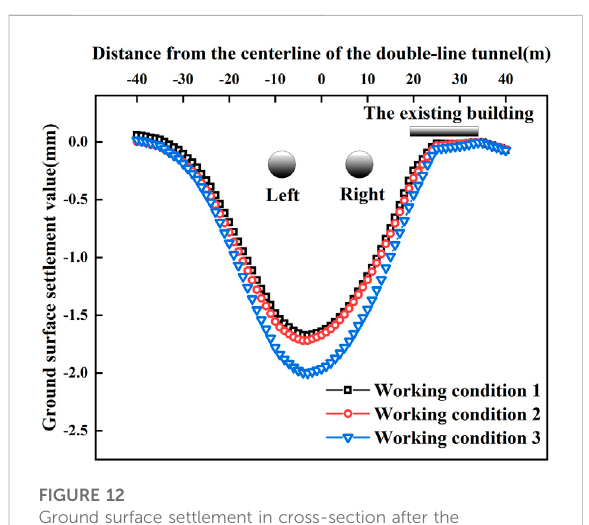
FIGURE 12 Ground surface settlement in cross-section after the completion of double-line construction (K36 + 250).